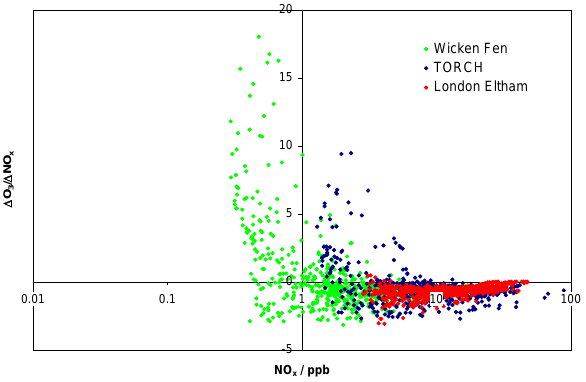
Fig. 15. Hourly modelled values at three sites (Wicken Fen – green; Figure 15: Hourly modelled values at three sites (Wicken Fen – green; Writtle – blue; and Writtle – blue; and London Eltham – red) for the whole of August of the ratio 1 O 3 / 1 NO x (where 1 is the change in mixing ratio be- London Eltham – red) for the whole of August of the ratio Δ O 3 / Δ NO x (where Δ is the change tween the base experiment and the 50% NO x reduction experiment), in mixing ratio between the base experiment and the 50% NO x reduction experiment), plotted plotted as a function of base experiment NO x . as a function of base experiment NO x .